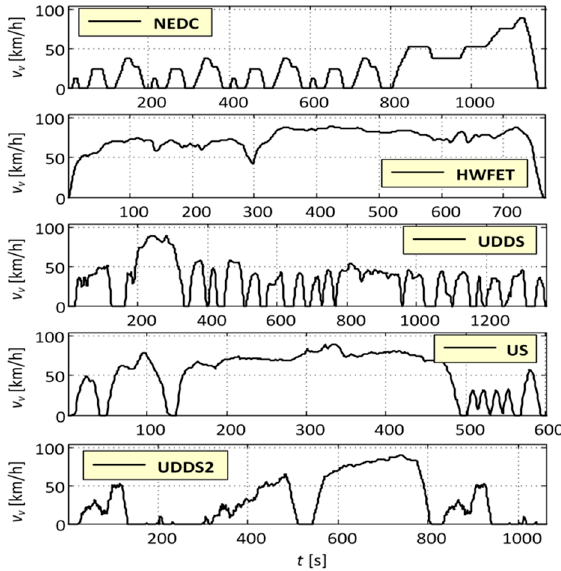
Figure 6. Certification driving cycles [24].